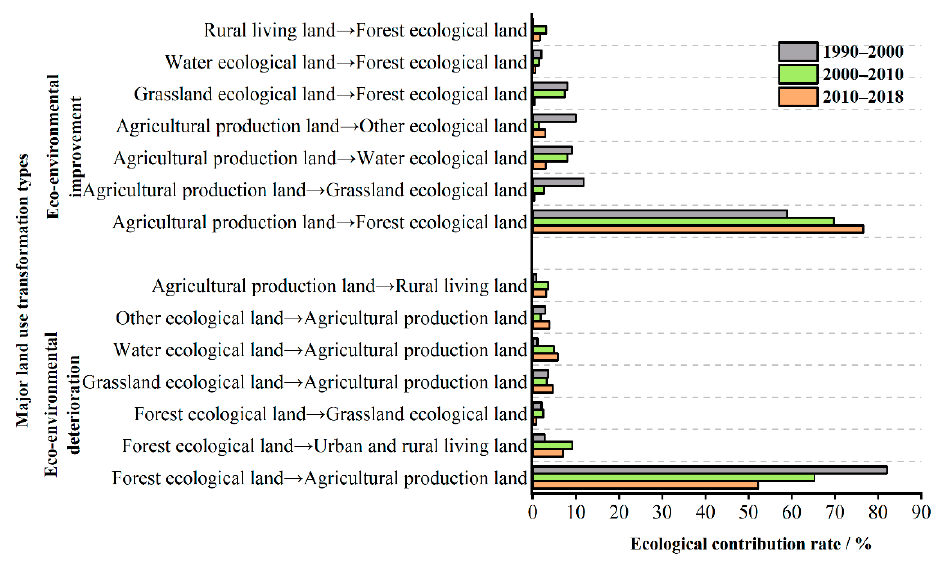
Figure 6. Major land-use transformation and contribution rates influencing the eco-environmental quality index.